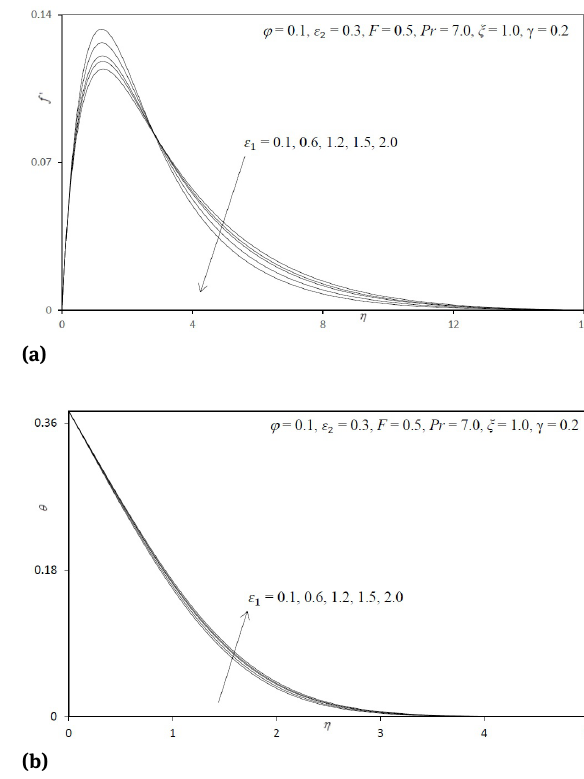
Fig. 4: (a) Effect of ϵ 1 on the Velocity Profiles; (b) Effect of ϵ 1 on Temperature